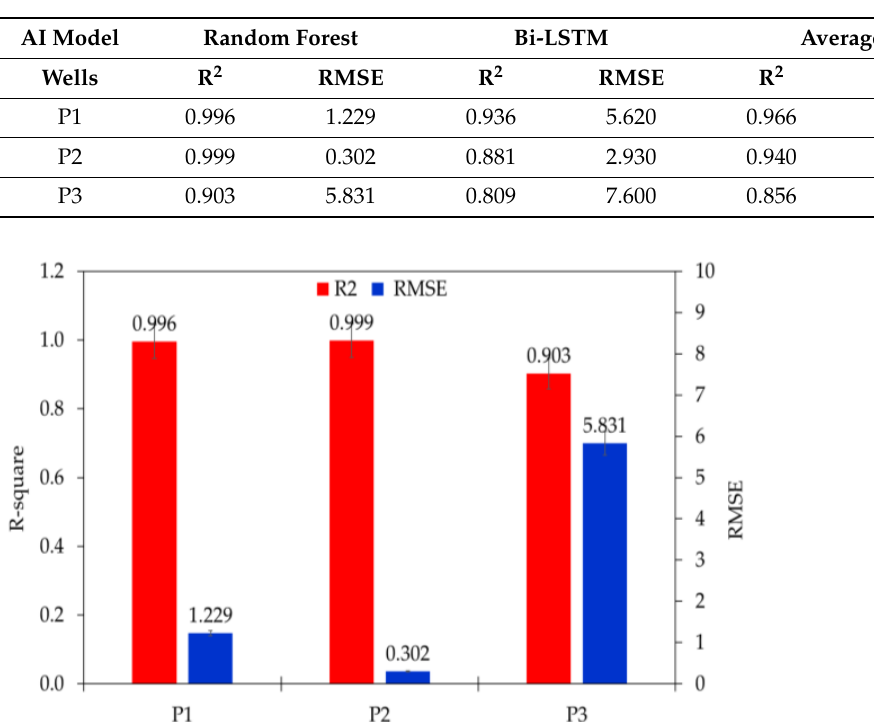
Table 5. R 2 and RMSE for single well DTS prediction.